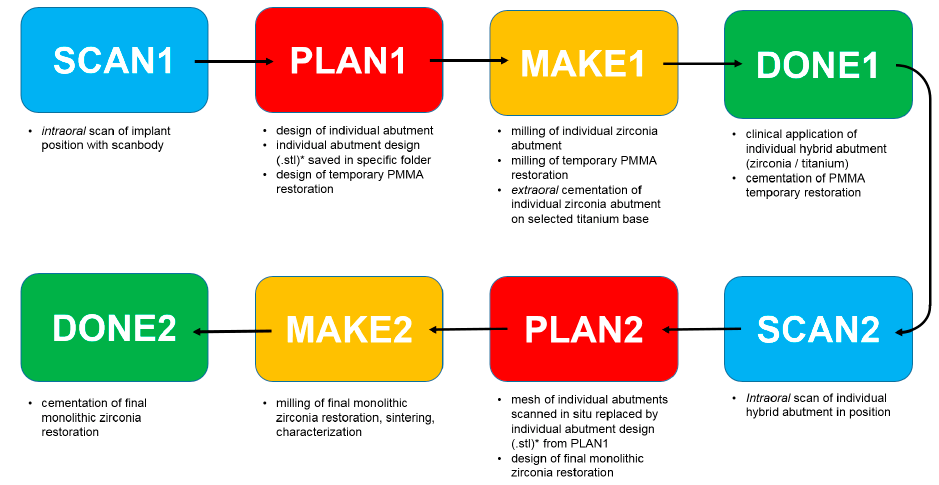
Figure 1. Schematic drawing of the patented full digital protocol (SCAN-PLAN-MAKE-DONE ® ) used in the present retrospective clinical study on 25 patients.